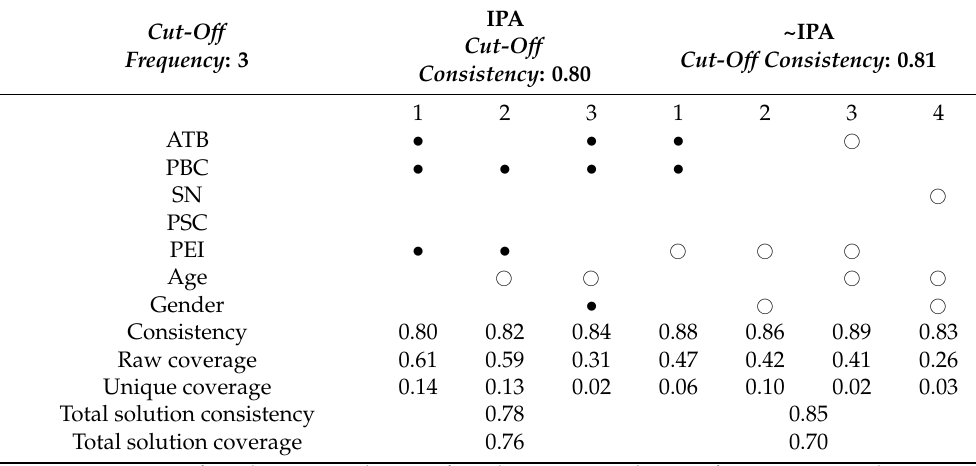
Table 5. Sufficient conditions (intermediate solution) for high and low levels of